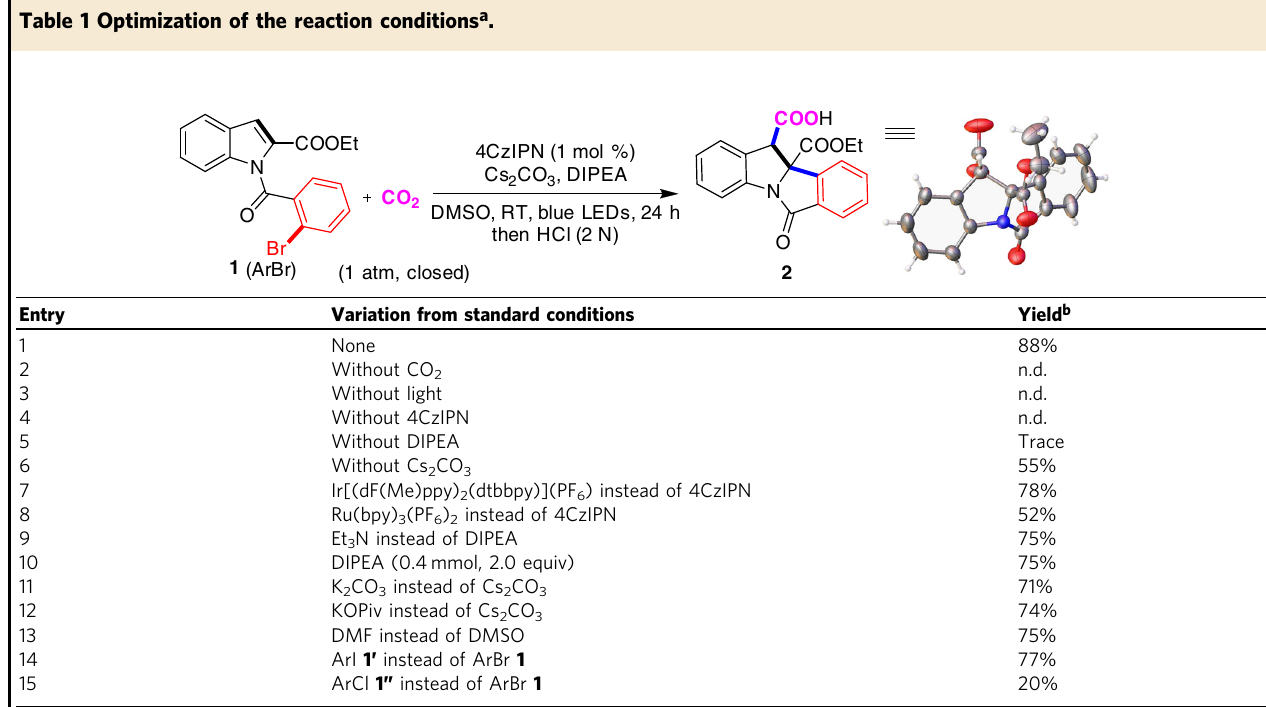
Fig. 2 Reductive dearomative difunctionalization of indoles. a Tandem Ni-catalyzed asymmetric reductive dearomative functionalization of indoles by using proton or alkyl bromides as another electrophile. b Visible-light-promoted reductive dearomative arylcarboxylation of indoles with CO 2 via SSET process, in which carbon centered benzylic radical and benzylic anion as key intermediate. PC photocatalyst.